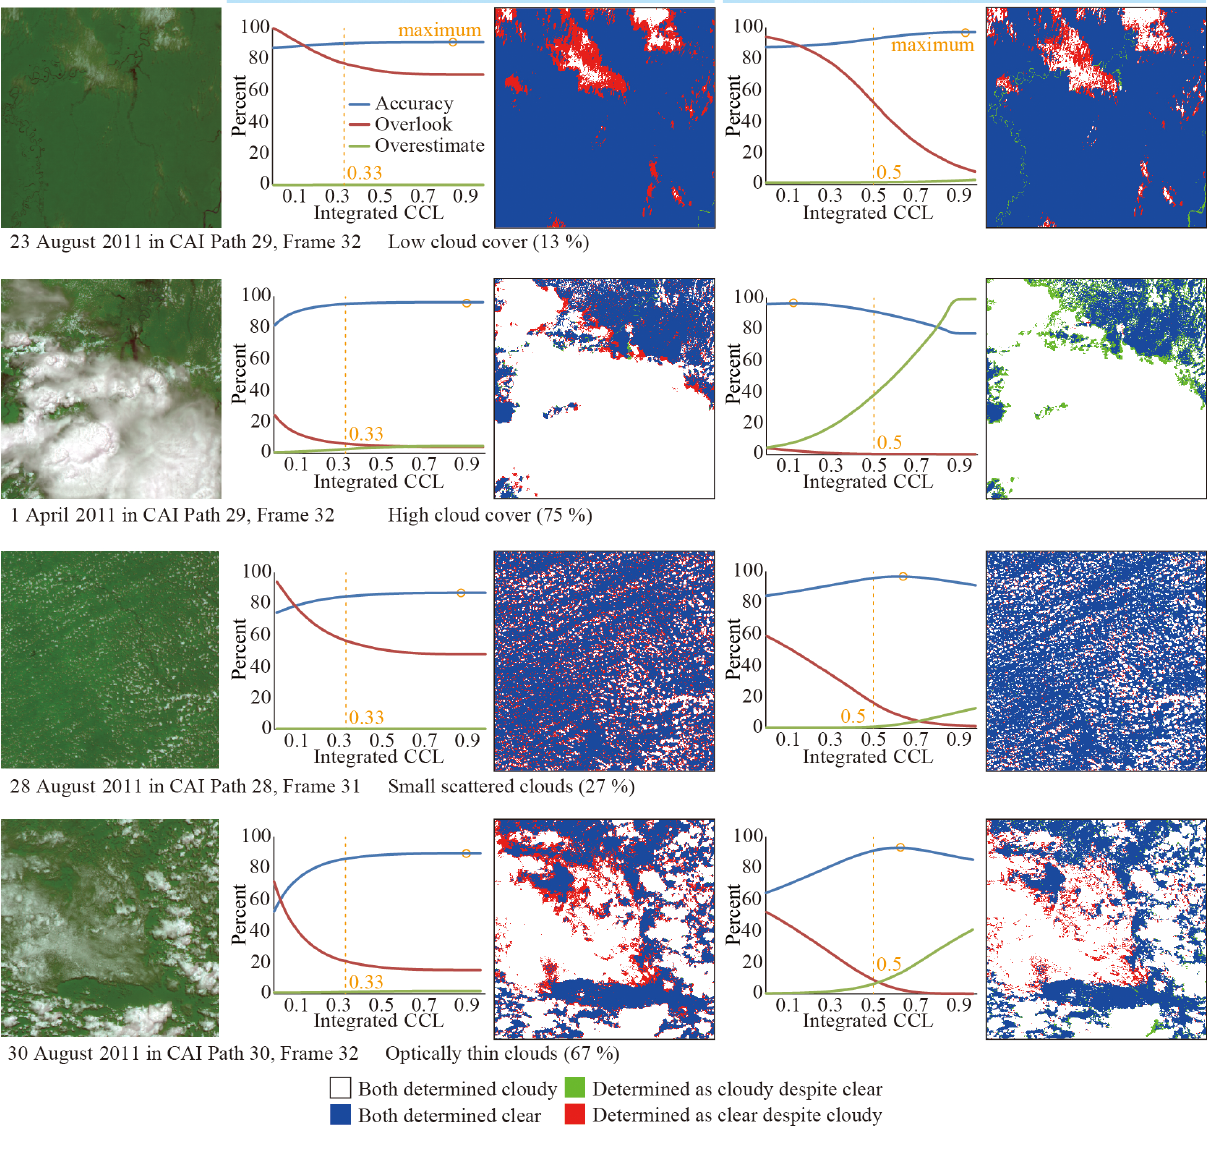
Figure 11. Comparison of the visual inspection images and the output images in the Amazon. Orange circles indicate the maximum accuracy values. Orange dotted lines indicate the integrated-CCL thresholds. Blue line indicates the accuracy, red line indicates the overlook, and green line indicates the